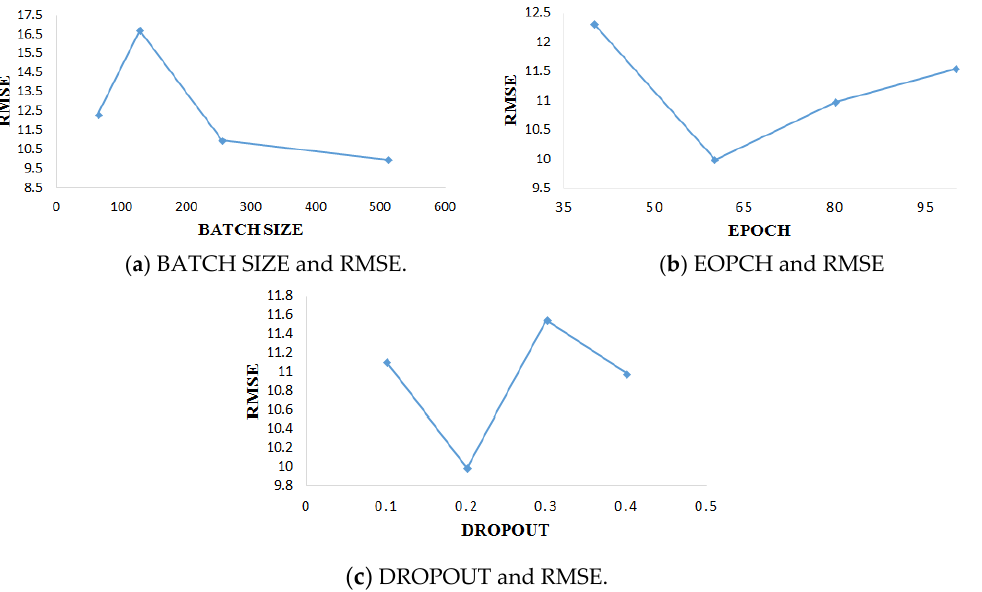
Figure 11. Experimental results of different parameters of FD003. After model training and comparative analysis of experimental results, the parameter setting of FD001 and FD003 data subsets with the best model performance is finally obtained, as shown in Table